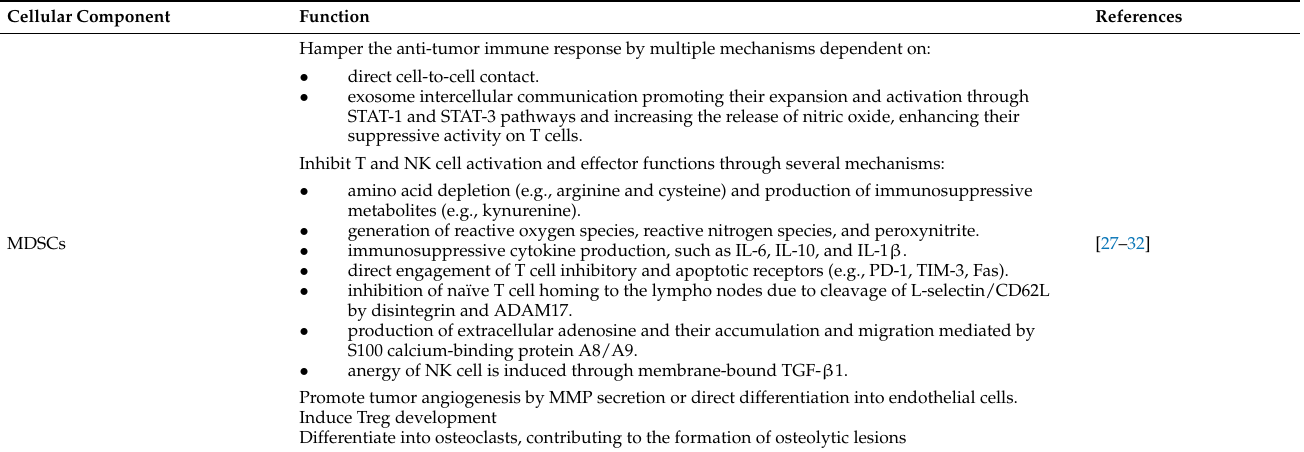
Table 2. Cellular component of the bone marrow microenvironment in MM pathogenesis. Cellular